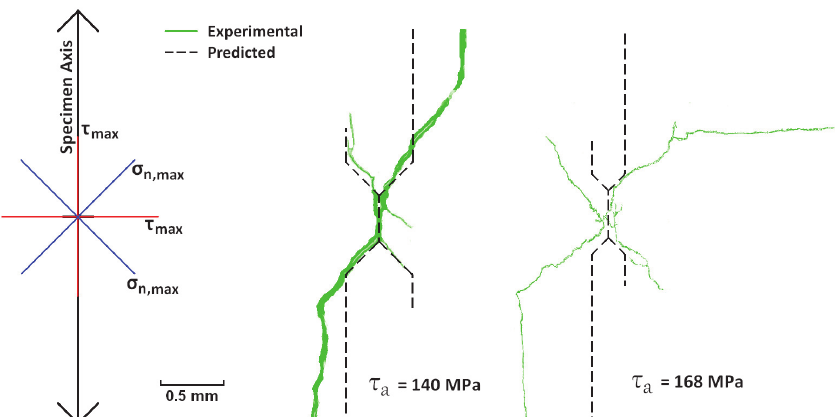
Figure 9: Experimental vs. predicted crack path based on maximum growth rate criterion and proposed crack friction